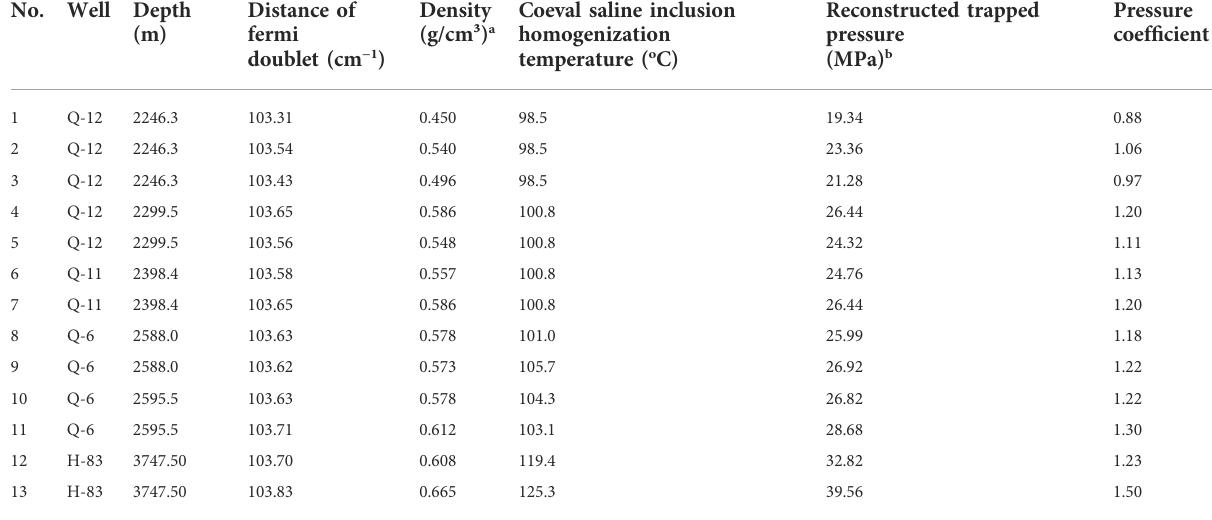
TABLE 2 Summary of Raman quantitative analysis of pure CO 2